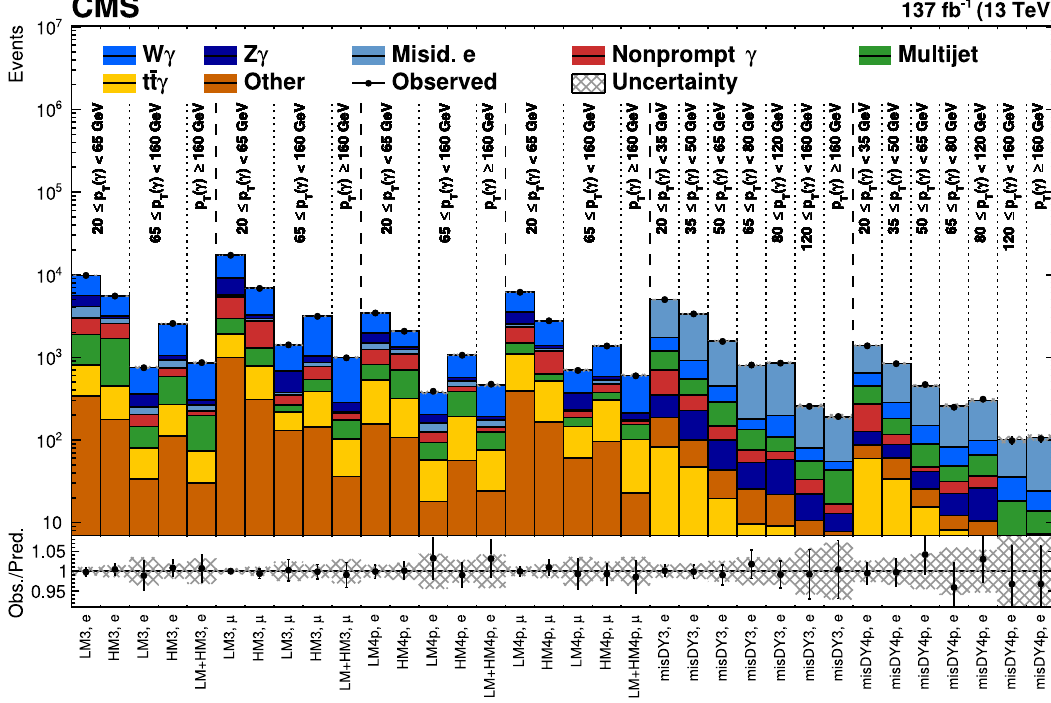
Figure 5 . Fitted and observed yields in the LM3, LM4p, HM3, HM4p, misDY3, and misDY4p control regions using the post-fit values of the nuisance parameters. The lower panel shows the ratio of the observed to the predicted event yields. The post-fit systematic uncertainties are shown as a hatched band.